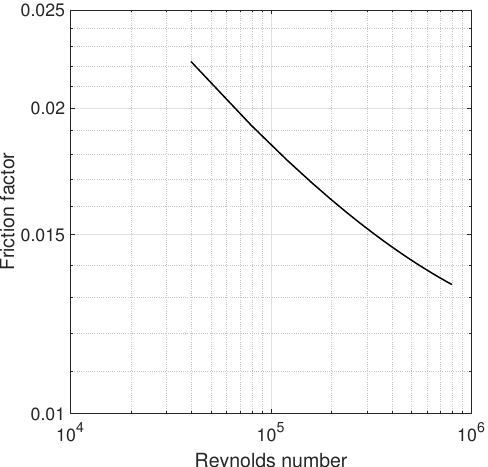
Figure 5. Moody diagram of the duct used for experimental measurements.